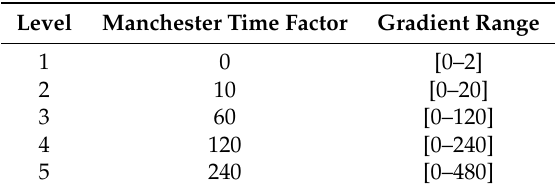
Table 6. Urgency levels and expected waiting times according to the Manchester Standard of Triage [37] (in minutes) and the range defined for the Gradient Map for Process Mining